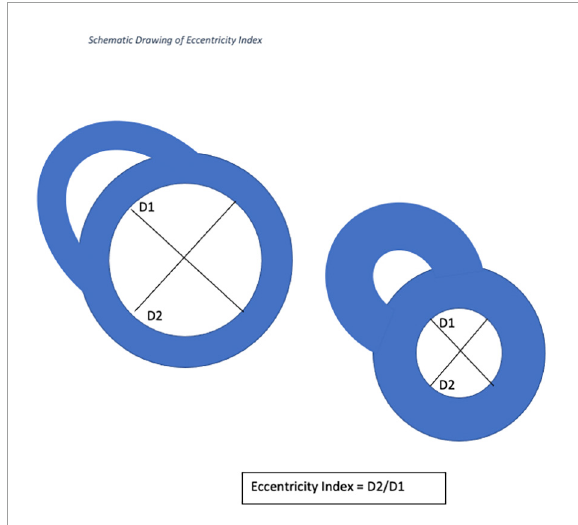
FIGURE2 Schematic drawing of eccentricity index calculation during systole and diastole.